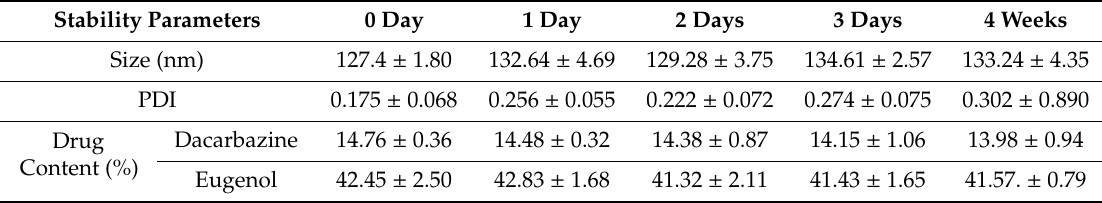
Table 7. Storage Stability